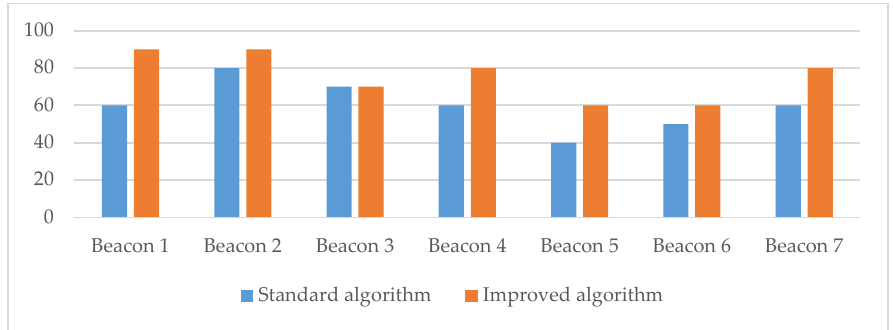
Figure 15. The success rate of correct transmitter detections for the controlled room environment with a medium density of obstacles.